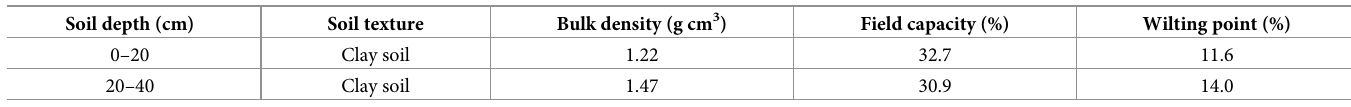
Table 1. Basic physical soil properties of the experimental site. Soil depth (cm)